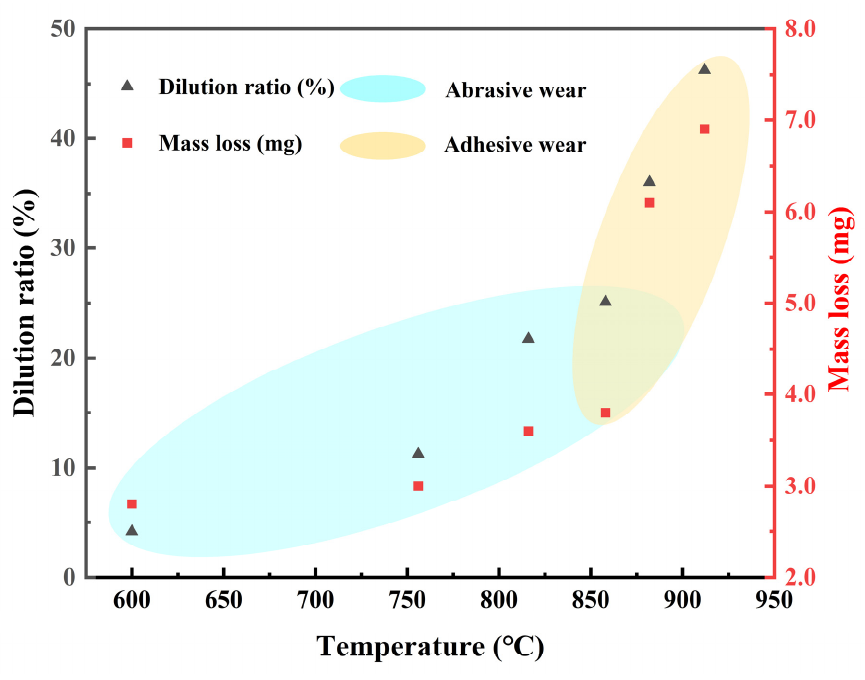
Figure 14. Summary diagram of the relationship between cladding temperature, dilution ratio and mass